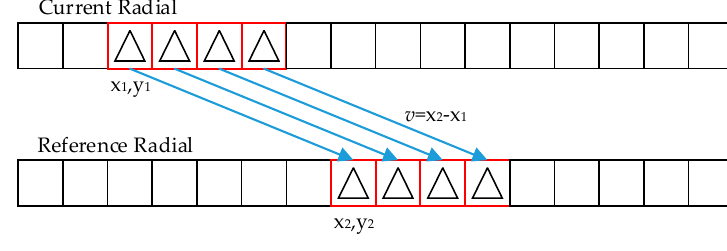
Figure 5. Prediction between radials.